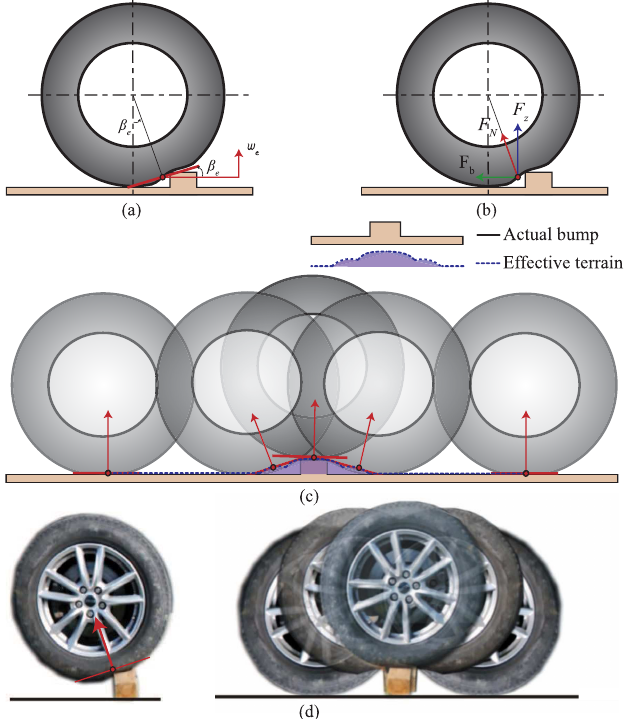
Fig. 8. Terrain filtering approach. (a) Effective plane height and angle; (b) dynamic tire load (components of the tire load normal to the effective plane F N : vertical F z and the horizontal F b also called as the bump resistance); (c) effective road terrain; (d) actual wheel deformation (left) and trajectory (right) over a bump during field trial.